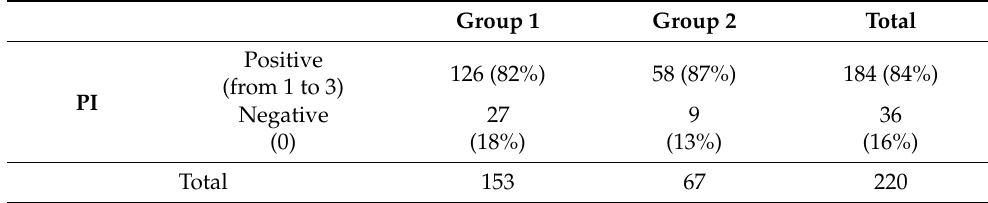
Table 7. Plaque index in Group 1 (EA ≥ 30 ◦ ) and Group 2 (EA < 30 ◦ ).